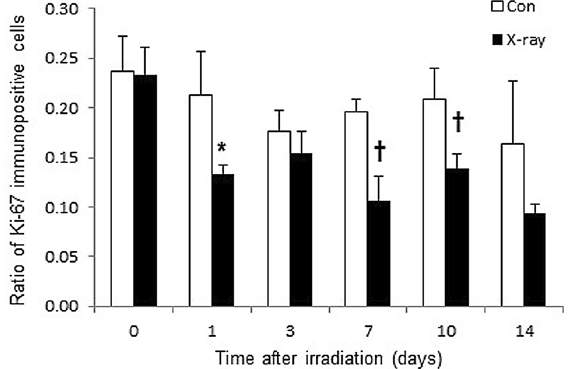
Figure 4. Semi-quantitative analysis of immunohistochemical expression of Ki-67 in LNZ308 tumors after irradiation. Tumors on right paws were irradiated on day 0 at the dose of 60 Gy. Each point represents mean ± SD of the ratio of Ki-67 immunopositive cells (n = 4). * p < 0.05 and † p < 0.01, as compared with control.